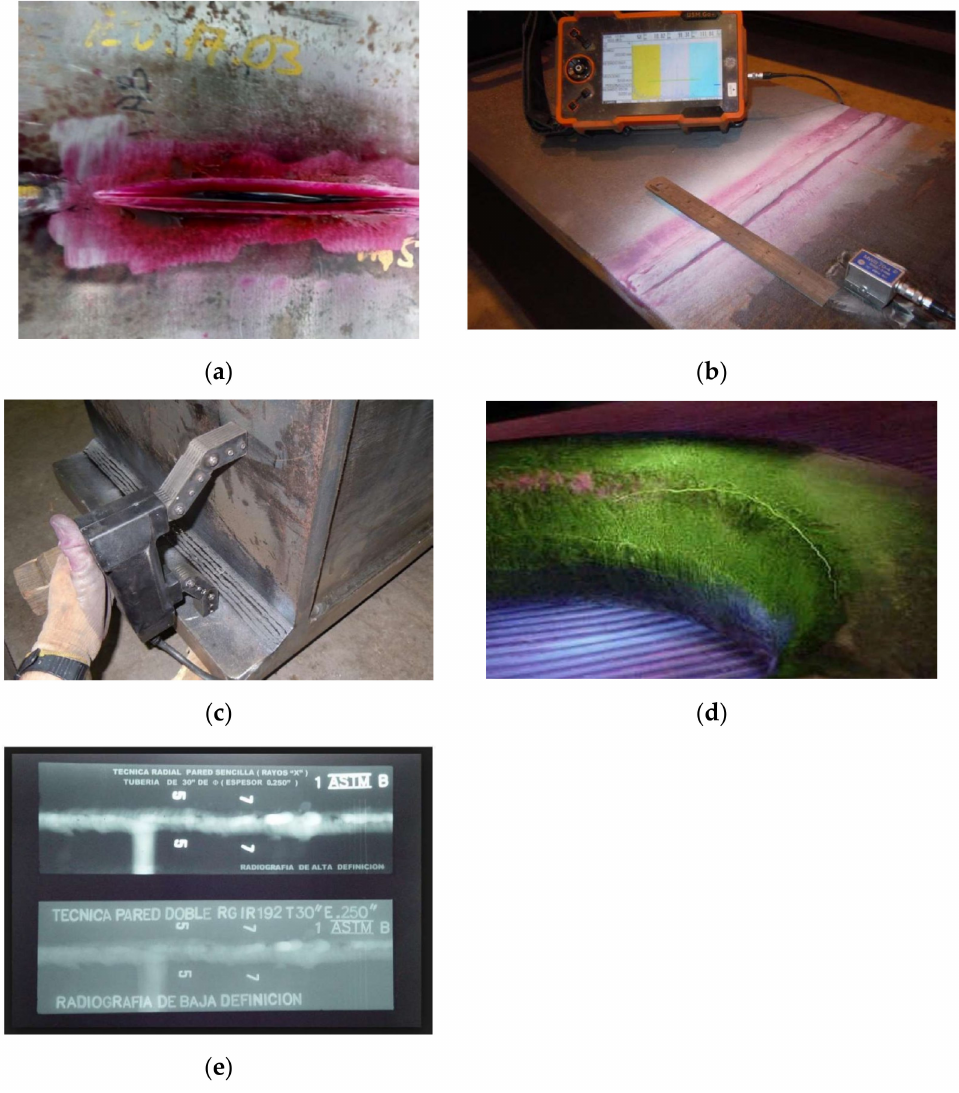
Figure 1. Non-destructive testing inspection: ( a ) penetrating liquids, ( b ) ultrasonic methods, ( c , d ) magnetic particles, and ( e )